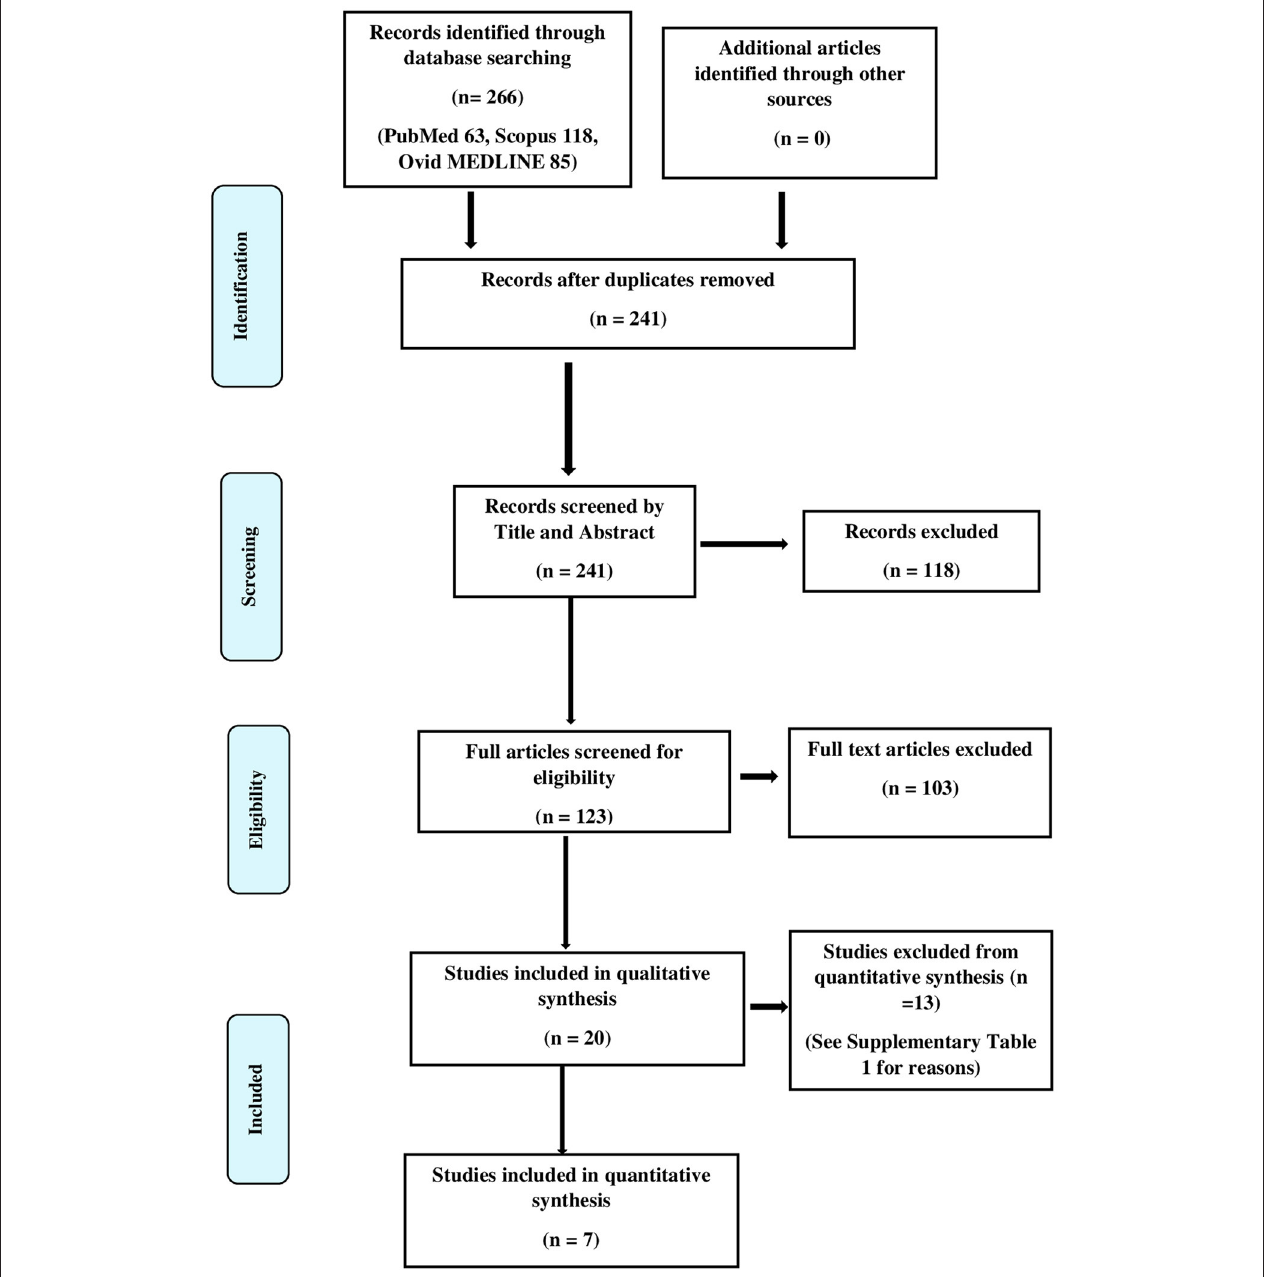
FIGURE 1 | Flowchart of the study